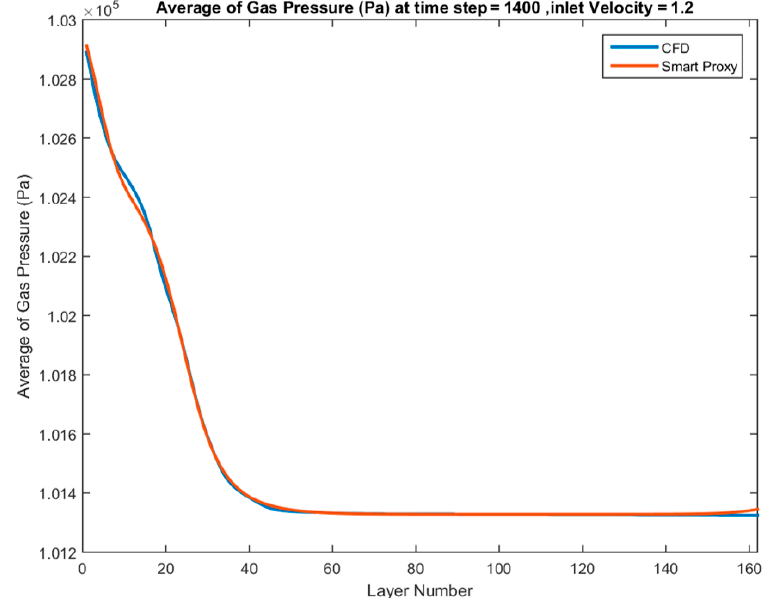
Figure 32. Spatially averaged CFD and smart proxy results for gas pressure (Pa) at time step = 1400 and V in = 1.2 m/s (with 4 static parameters).